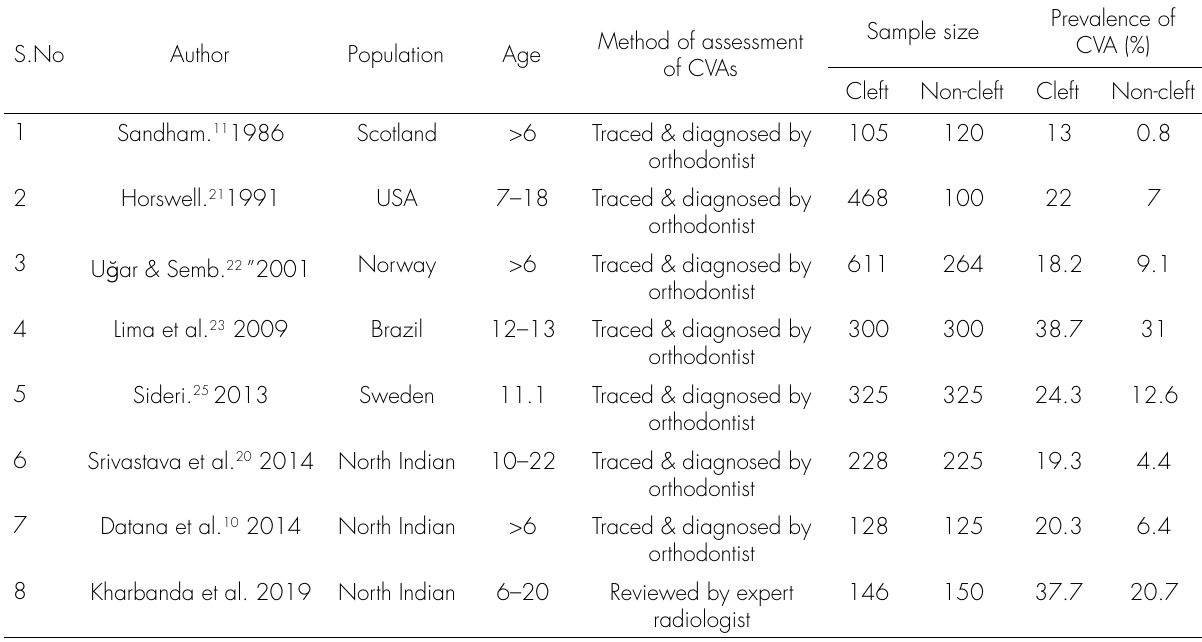
Table I. Prevalence of cervical vertebrae anomalies (CVA) reported in